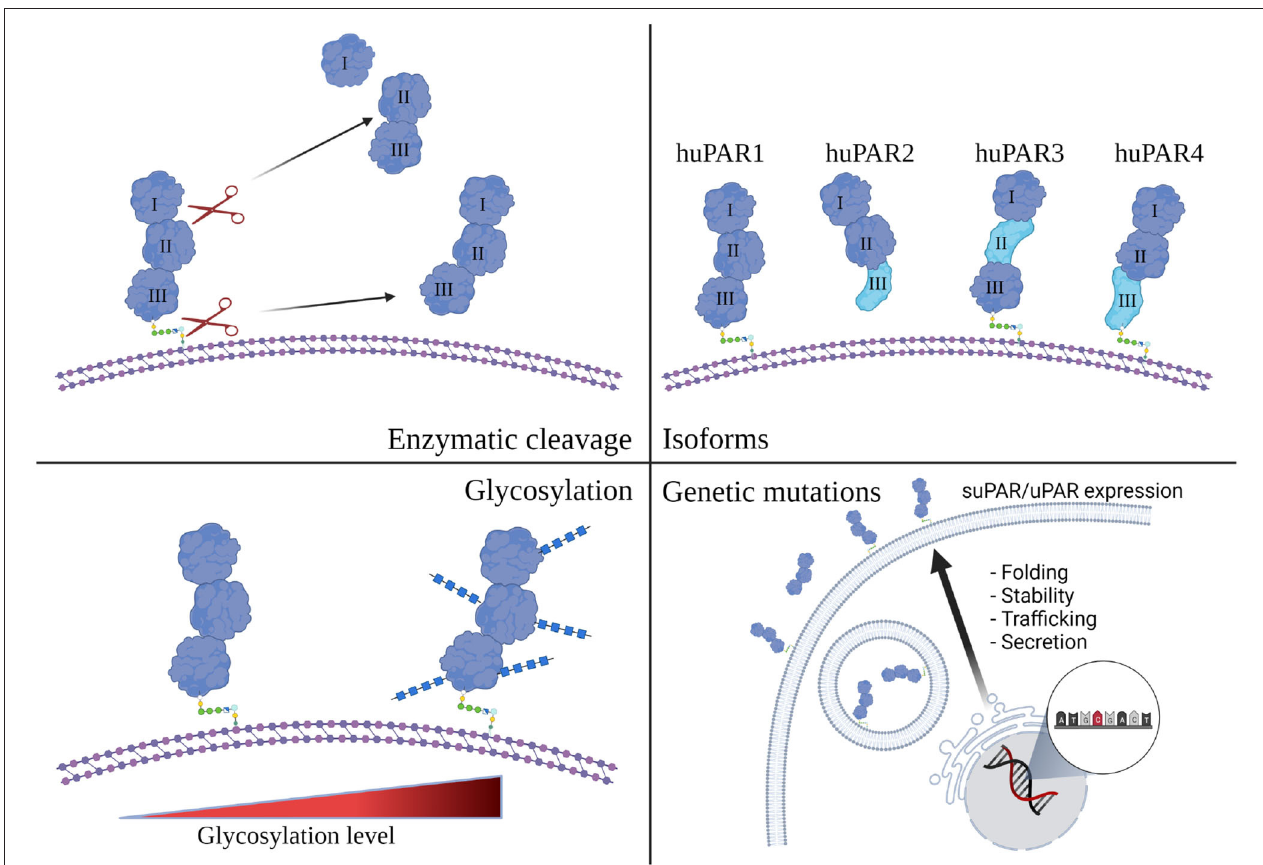
FIGURE 2 | Human suPAR, more than just one flavor. Schematic presentation of human uPAR and suPAR (Created with BioRender.com). While enzymatic cleavage has been considered to be the main source of suPAR, transcriptional splicing, genetic mutation, and post-translational glycosylation could also impact the composition and function of circulating suPAR in different human